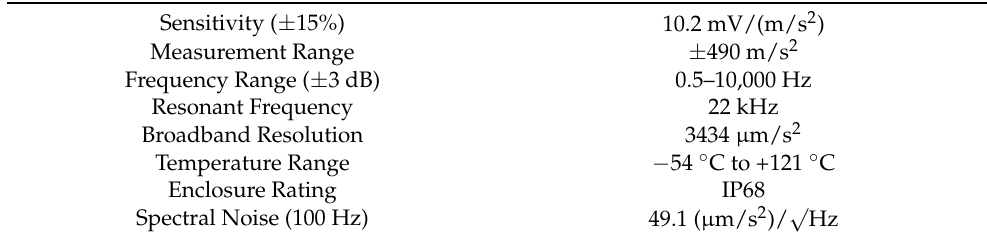
Table 1. Specifications of the accelerometer PCB Piezotronics